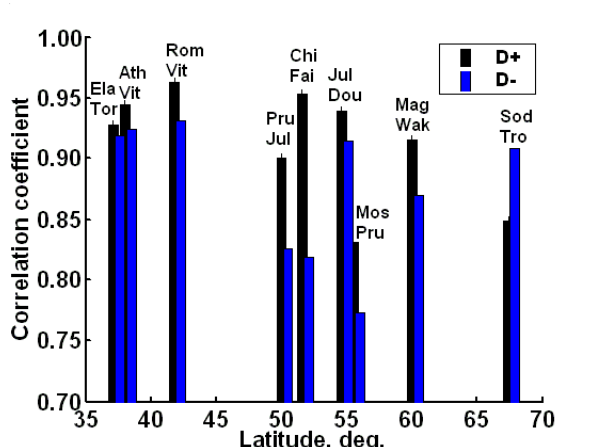
Fig. 3. Correlation coefficient between cloned and observed F2 layer critical frequency at clone site (upper abbreviation) deduced from parent site (lower abbreviation) at geodetic latitude of clone